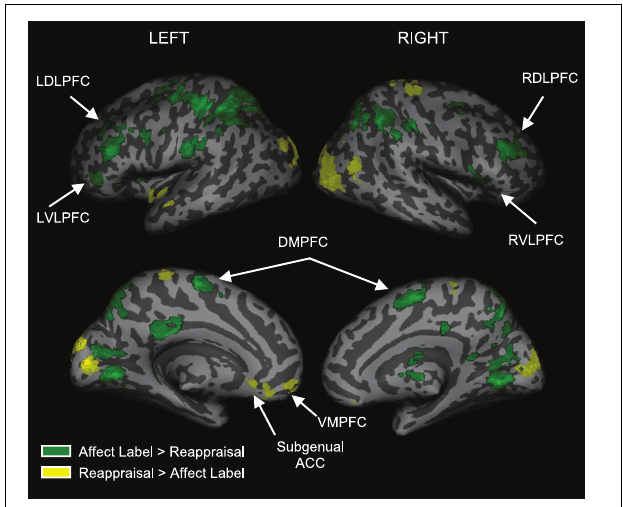
FIGURE 4 | Distinct activations for Labeling vs. Reappraisal. Areas in green represent greater activation for Labeling relative to Reappraisal. Areas in yellow represent greater activation for Reappraisal relative to